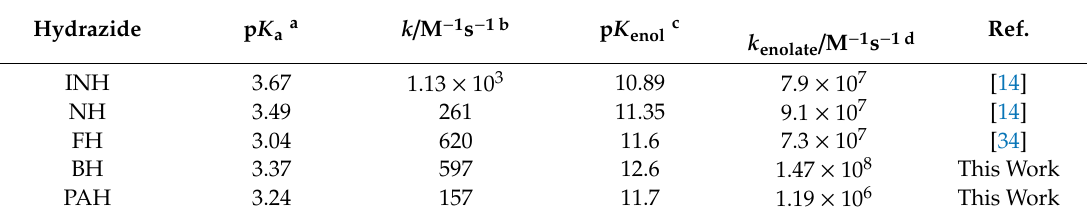
Table 4. A summary of the major results for the oxidations of hydrazides by [IrC l6 ] 2 − at 25.0 °C and μ = 1.0 M.